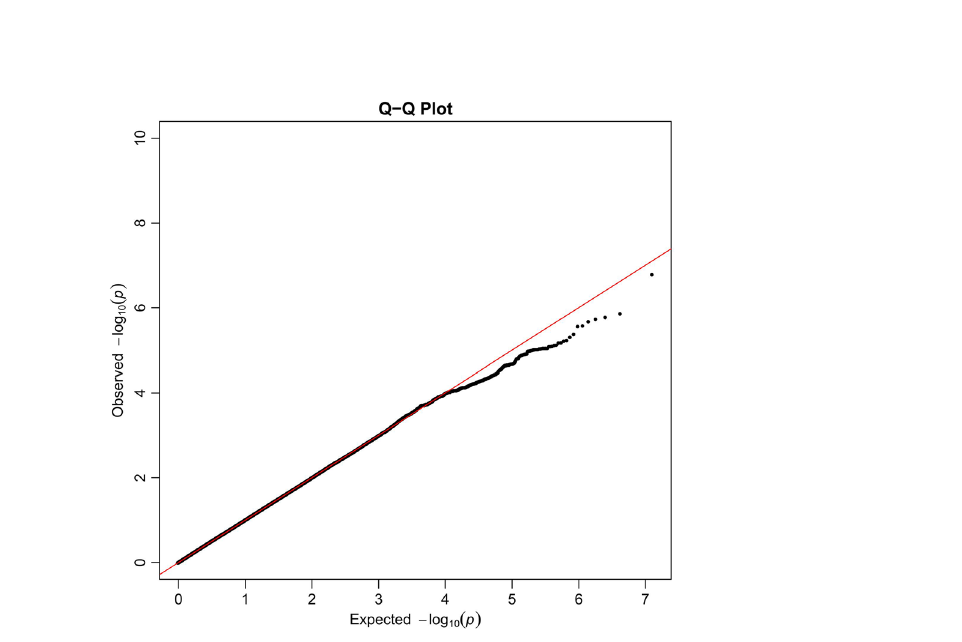
Figure 2. Quantile–quantile plots of log